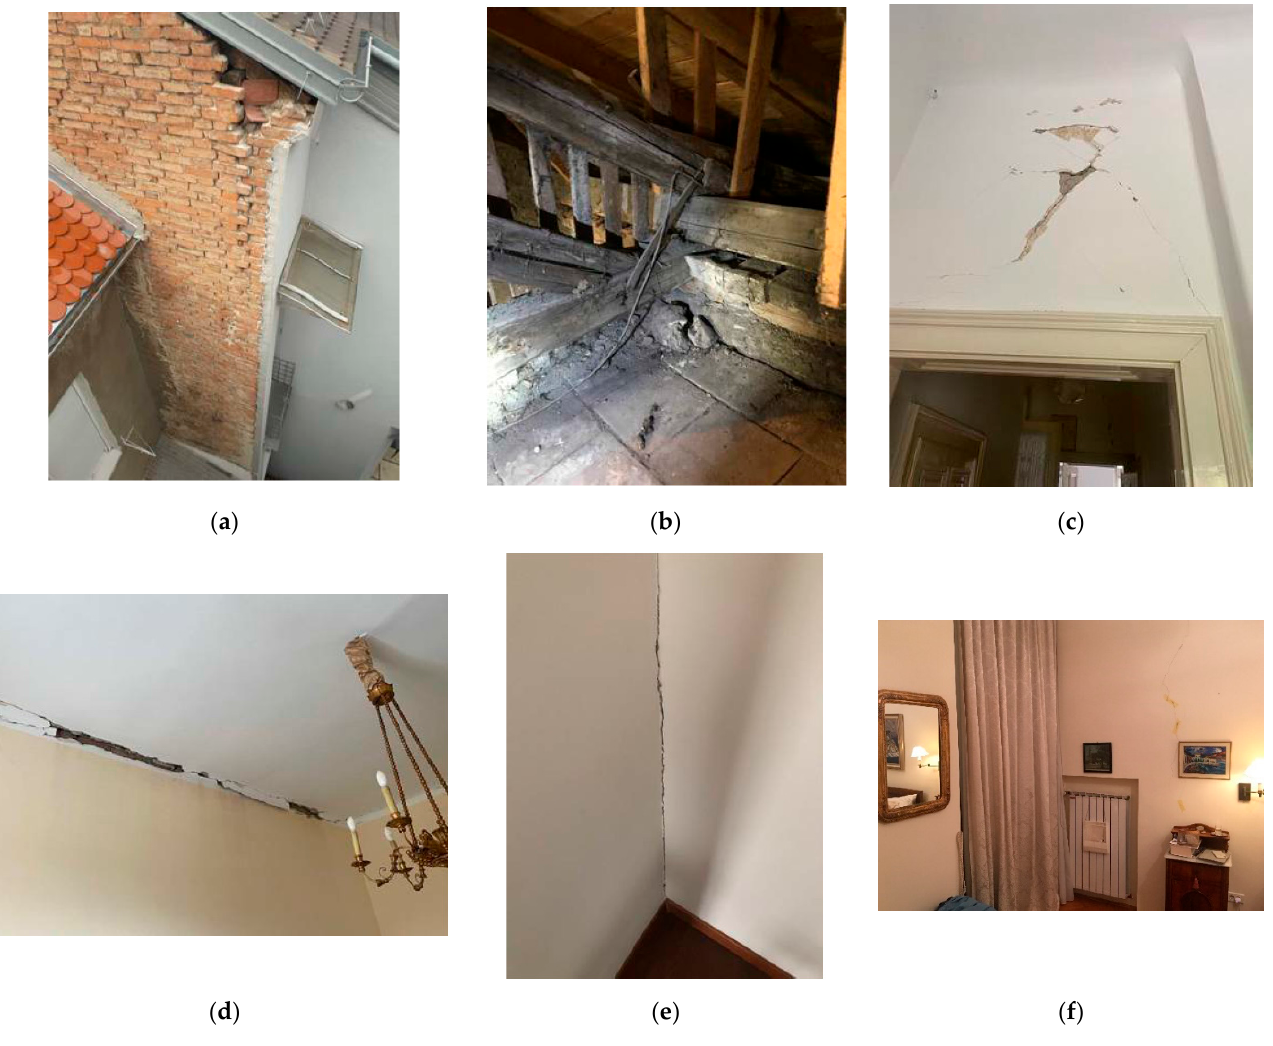
Figure 7. ( a ) Partial collapse of a gable wall; ( b ) oration of purlin’s; ( c ) damage in the spandrels; ( d ) cracks at the contact of the ceiling; ( e ) vertical crack at the contact of two walls; ( f ) vertical crack along the wall [32]. Reproduced with permission from Projekt na kvadrat d.o.o., 2022.